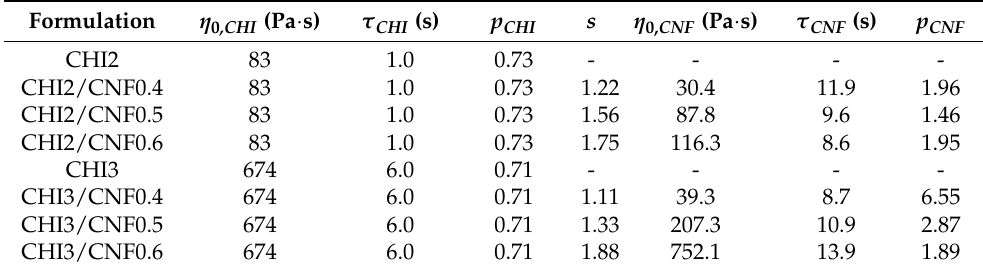
Table 2. Flow parameters determined from the viscosity vs. shear rate curves (Figure 2) of different CHI/CNF compositions, by using the Cross model (Equation (1)) for naked CHI inks and double Cross model (Equation (2)) for CHI/CNF